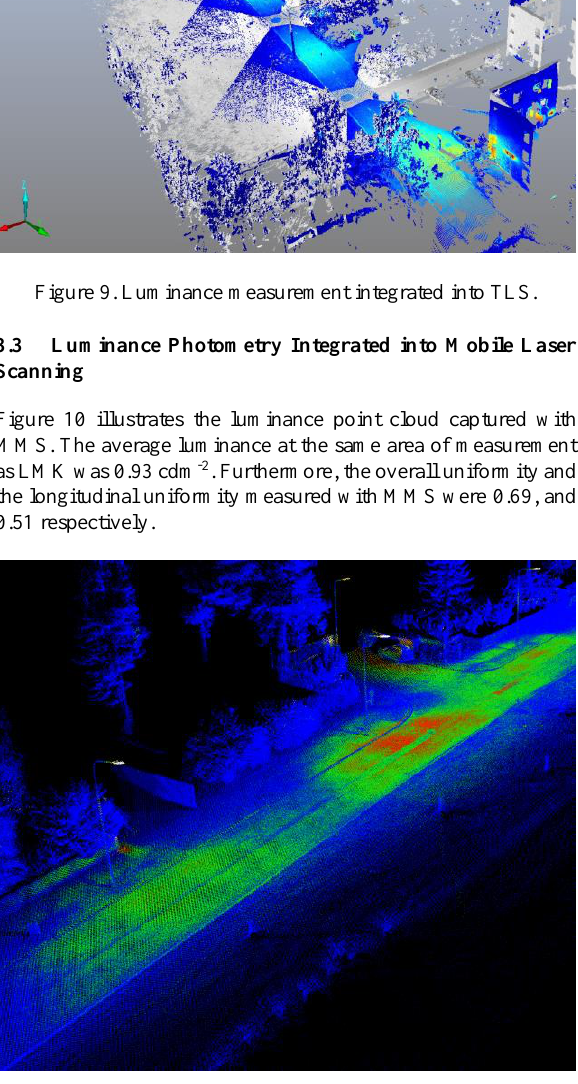
Figure 10. Luminance point cloud from the Trimble MX2 mobile mapping